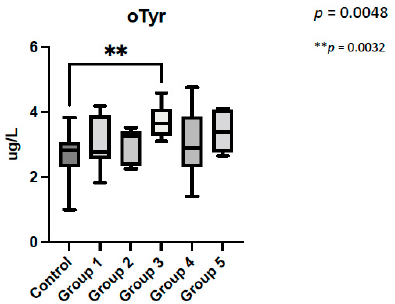
Figure 6. Ortho-Tyrosine levels depending on our congenital heart disease classification. The global p of the analysis was p = 0.0048. ** p = 0.0032, remarks the p obtained in the post-hoc analysis when controls and group 3 were compared. o-Tyr: ortho-tyrosine.